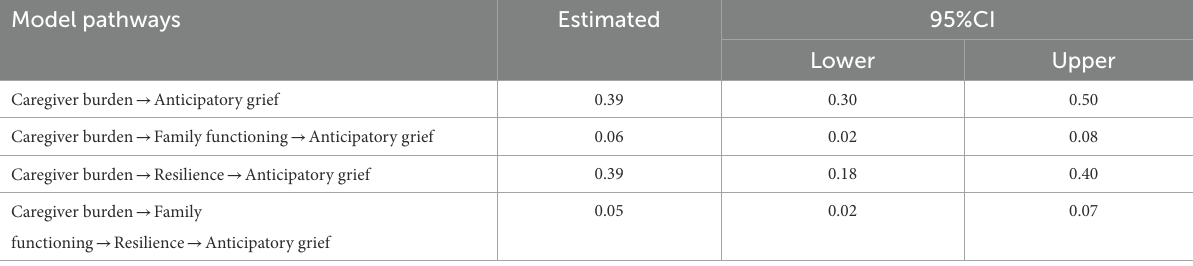
TABLE 4 Bootstrapping direct and indirect effects and 95% confidence intervals (CI) for the mediational